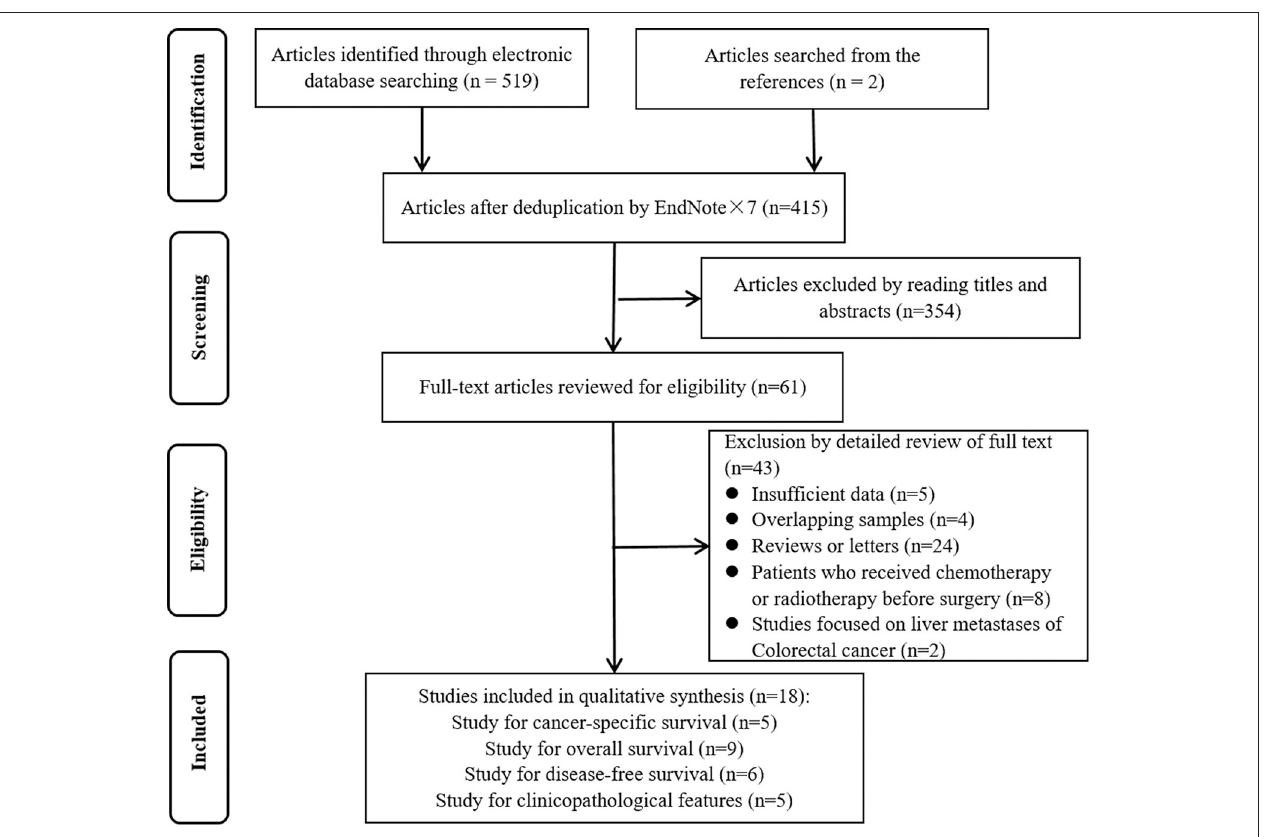
FIGURE 1 | Flowchart of study